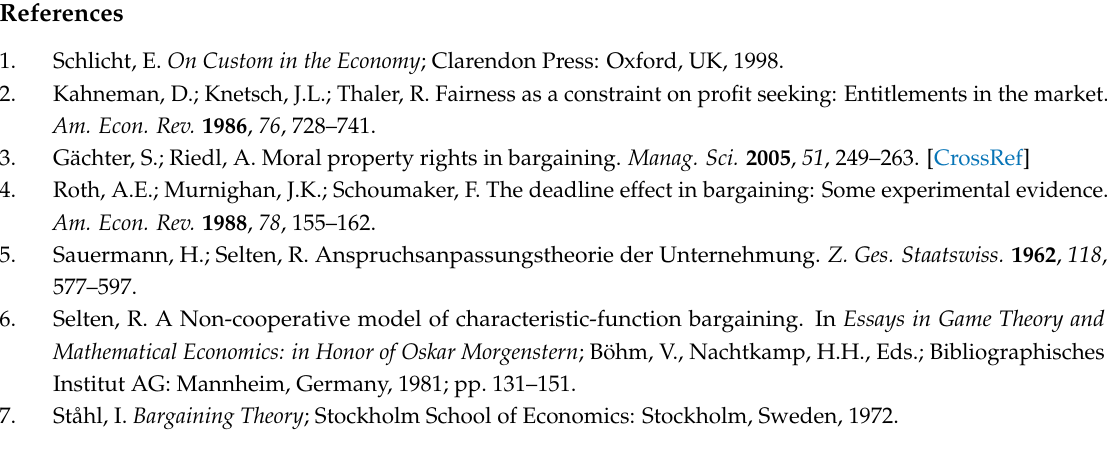
Figure A2. Session 6 in CHI.